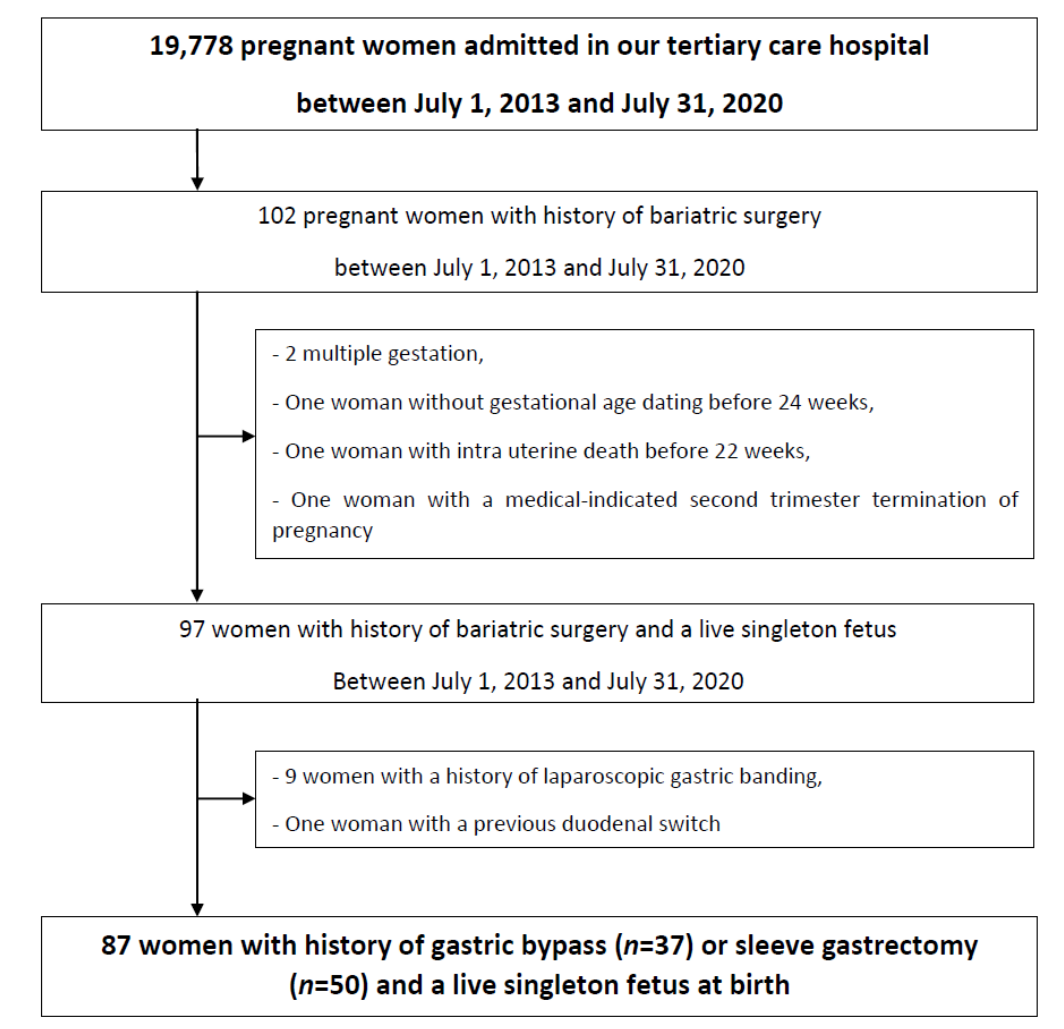
Figure 1. Flow chart.